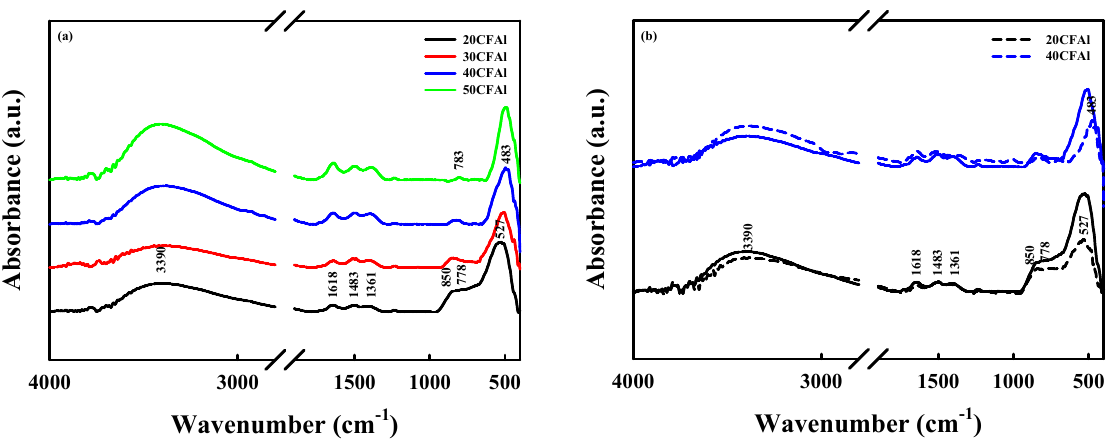
Figure 3. FT-IR spectra of the calcined and reduced CFAl catalysts: ( a ) calcined and ( b ) H 2 -reduced at 500 °C. In frame ( b ), the calcined samples are depicted for comparison.